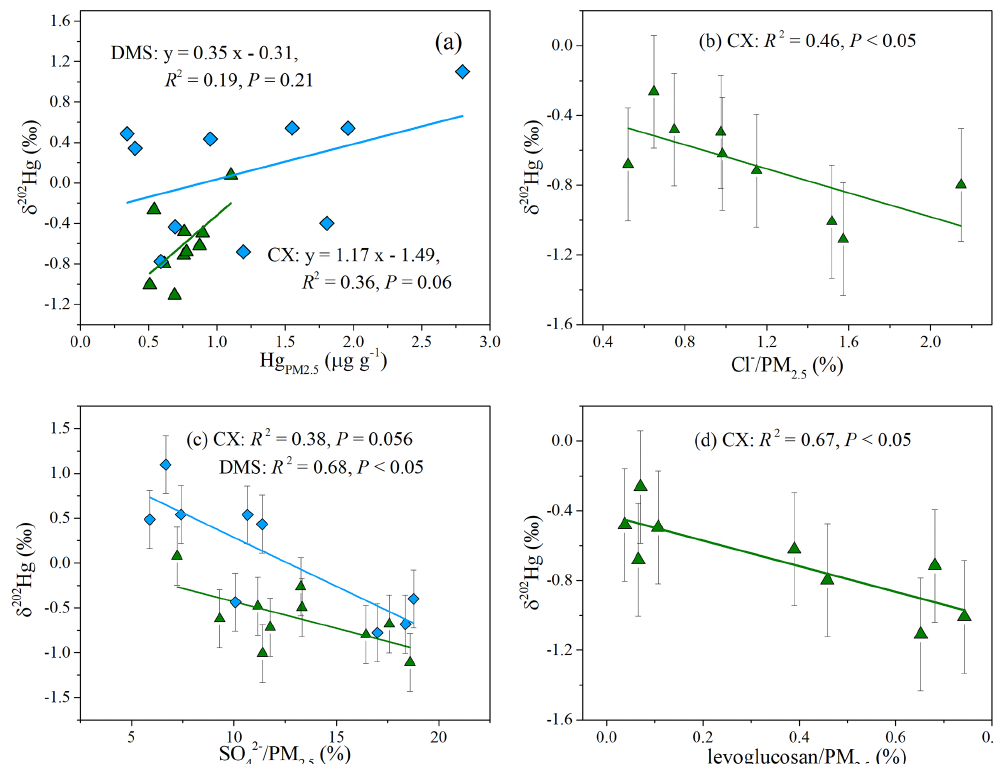
− , and (d) levoglucosan contents in PM 2 . 5 at the CX site (green triangle) 4